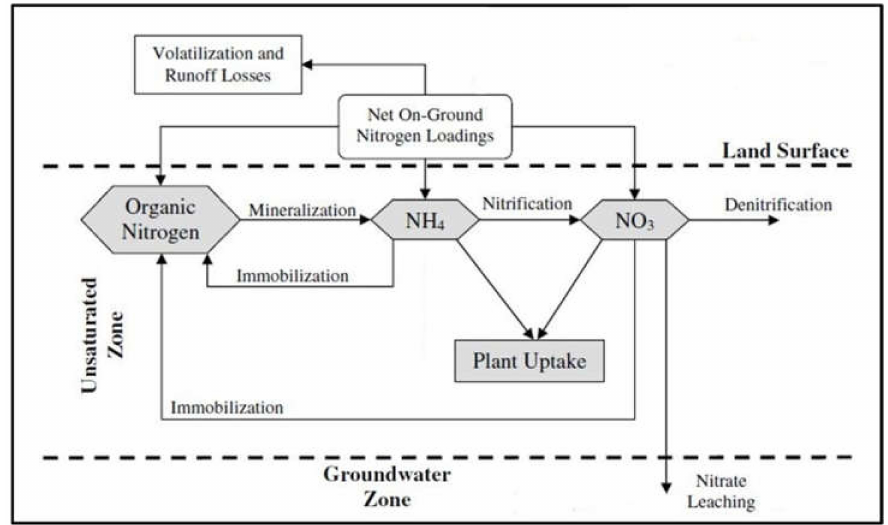
Figure 9. Schematic describing the integrated approach to predict nitrate leaching to